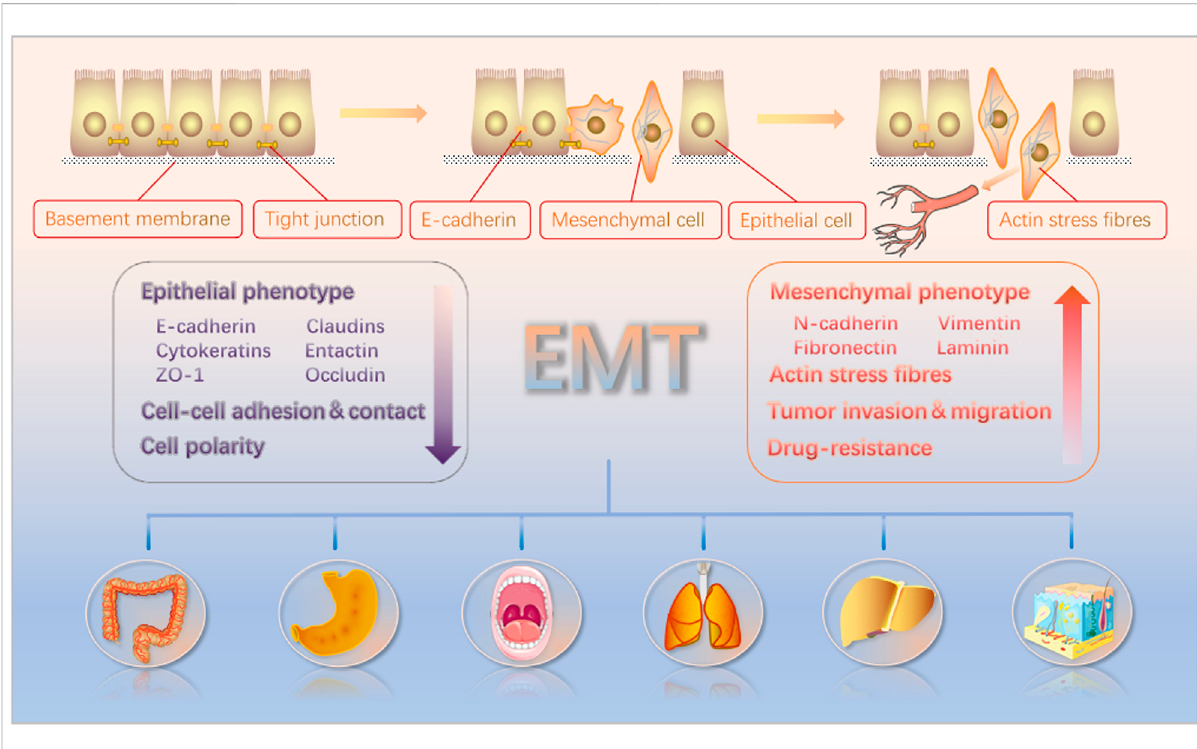
FIGURE 1 EMT causes polarized epithelial cells to acquire characteristics similar to motile mesenchymal cells. These cells can then detach from the basement membrane and disseminate from the whole body through the bloodstream. The EMT induction results in enhanced tumor cell invasion, migration,andresistancetodrugtreatment.Furthermore,epithelialandmesenchymalbiomarkersandtheirchangesinthecontextofEMTinduction are noted in the fi